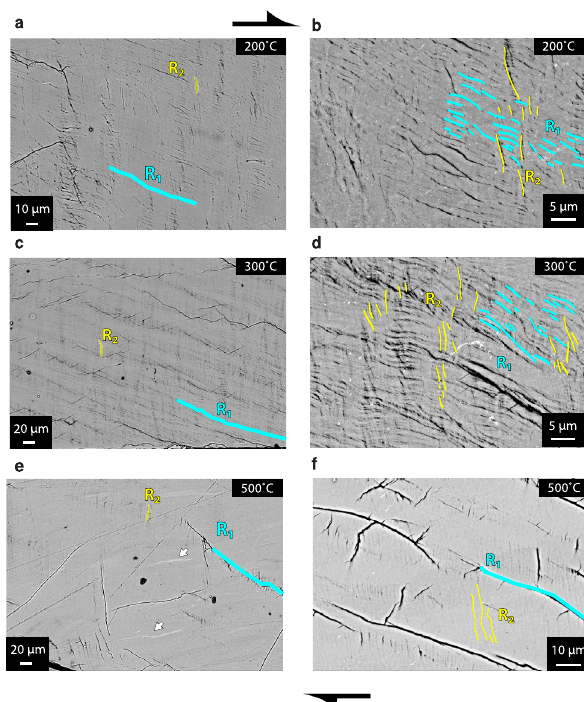
Fig. 3 Microstructural observations of nanocrystalline fault rocks in BSE. a R 1 oriented fractures (cyan) at 200 °C. Local kinks give rise to R 2 orientation (yellow). b High-magni fi cation image of microstructure at 200 °C, note pervasive, short R 1 oriented fractures and R 2 oriented features. c Microstructure at 300 °C with pervasive R 1 and R 2 shears. d High- magni fi cation image showing pervasive, short R 1 oriented fractures and R 2 oriented kink-bands. e Microstructure at 500 °C, note smeared out domains of different z-contrast (arrows). R 1 fractures form along an array of closely spaced, fi ne R 2 oriented fractures. Note the denser appearance with lower porosity compared to lower T experiments. f Detail of en-echelon R 2 oriented features.